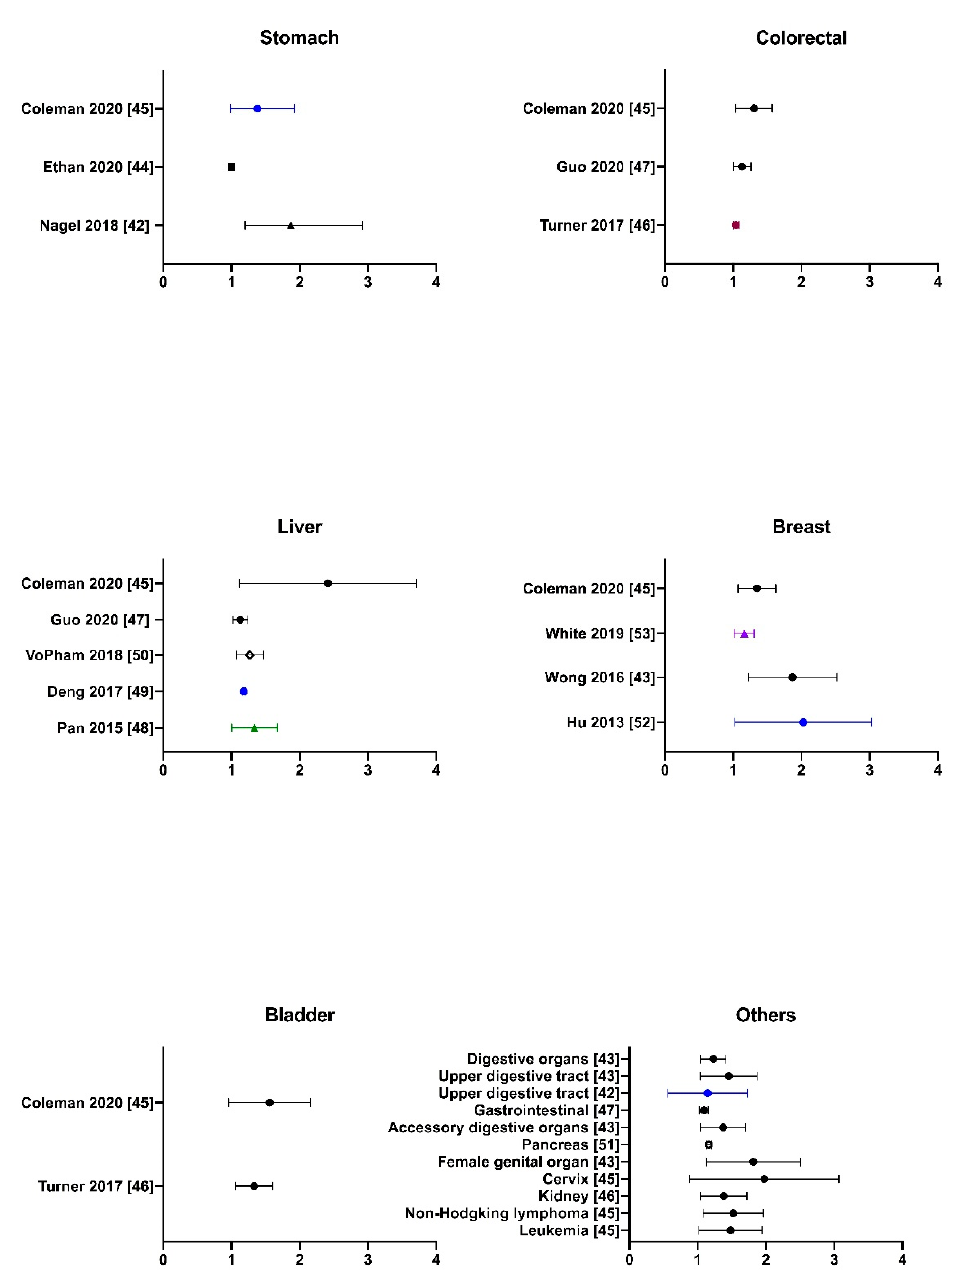
Figure 2. The risk of cancer mortality and/or incidence for extrapulmonary cancer per increment of PM2.5 from 1 μ g/m 3 to 10 μ g/m 3 . The illustration is of the comparisons between the hazard ratios (95% CI) of increased PM2.5 with various types of non-lung cancer, including stomach, colorectal, liver, breast, bladder and others. Note: the HR for cancer incidence is symbolized as a triangle, whereas the HR for cancer mortality is symbolized as a circle. There are two exceptional studies that examined the risk ratio, which is marked with a square, or incident rate ratio, which is marked with a diamond. Different colors represent different increments of PM2.5, in which black, blue, pink, purple, and green correspond to 10 μ g/m 3 , 5 μ g/m 3 , 4.4 μ g/m 3 , 3.6 μ g/m 3 , and 1 μ g/m 3 , respectively.